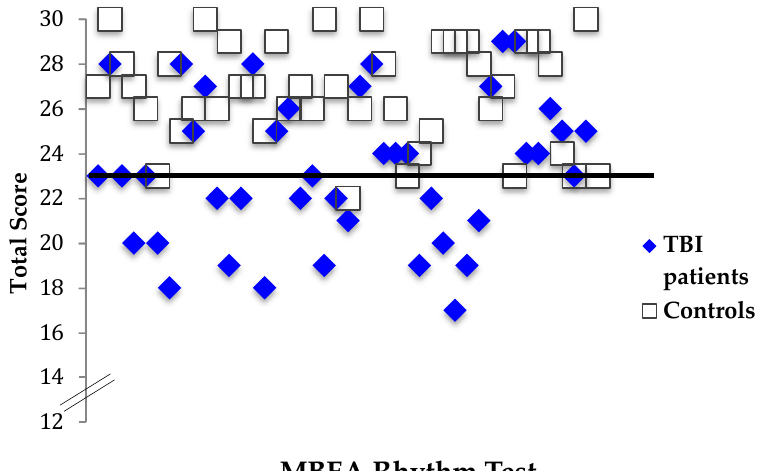
Figure 3. Individual scores for TBI patients and controls on the MBEA Rhythm test. Note. The black line represents the cutoff score for this test, which corresponds to two standard deviations below the mean (Peretz, 2003).